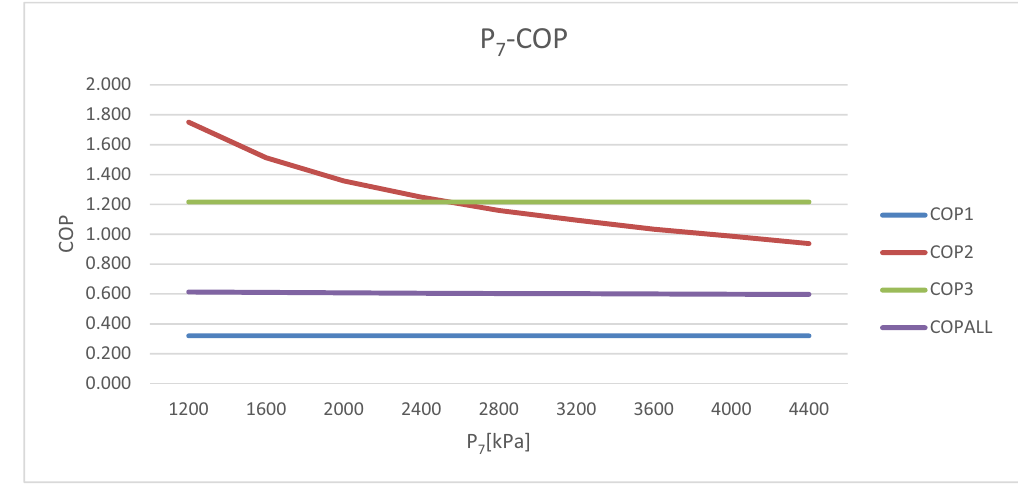
Figure 10: COP 1 , COP 2 , COP 3 , and COP all curves of the whole cycle obtained for di ff erent outlet pressures at which the second - stage compressor of the vapor compression three - stage cascade cryogenic cycle can